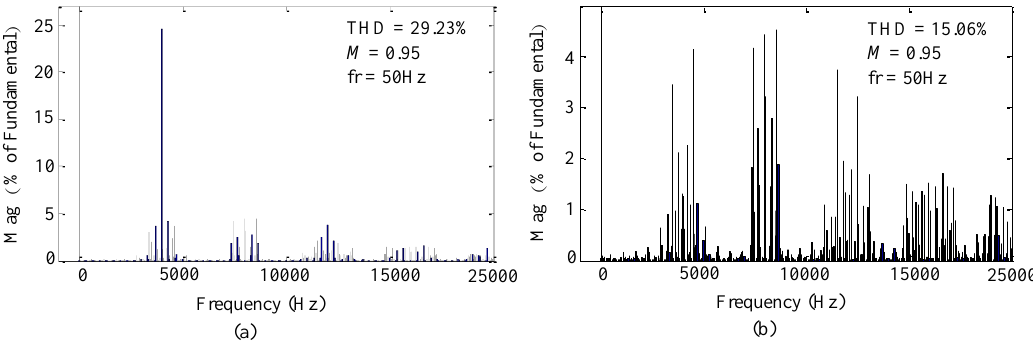
Figure 4. The spectrum of line voltage for a five-level cascaded H-bridge (CHB) inverter under different condition. Switching frequency is 1 kHz. Modulation depth, M = 0.95. Reference frequency is 50 Hz: ( a ) Harmonics profile of line voltage where the equivalent carriers for phase A and B are opposite in phase; ( b ) Harmonics profile of line voltage where the equivalent carriers for phase A and B are in phase.